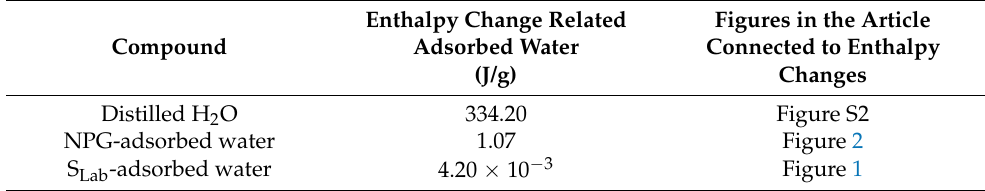
Table 1. Thermoanalytic data obtained by DSC for sample of water, S Lab , and NPG compound.